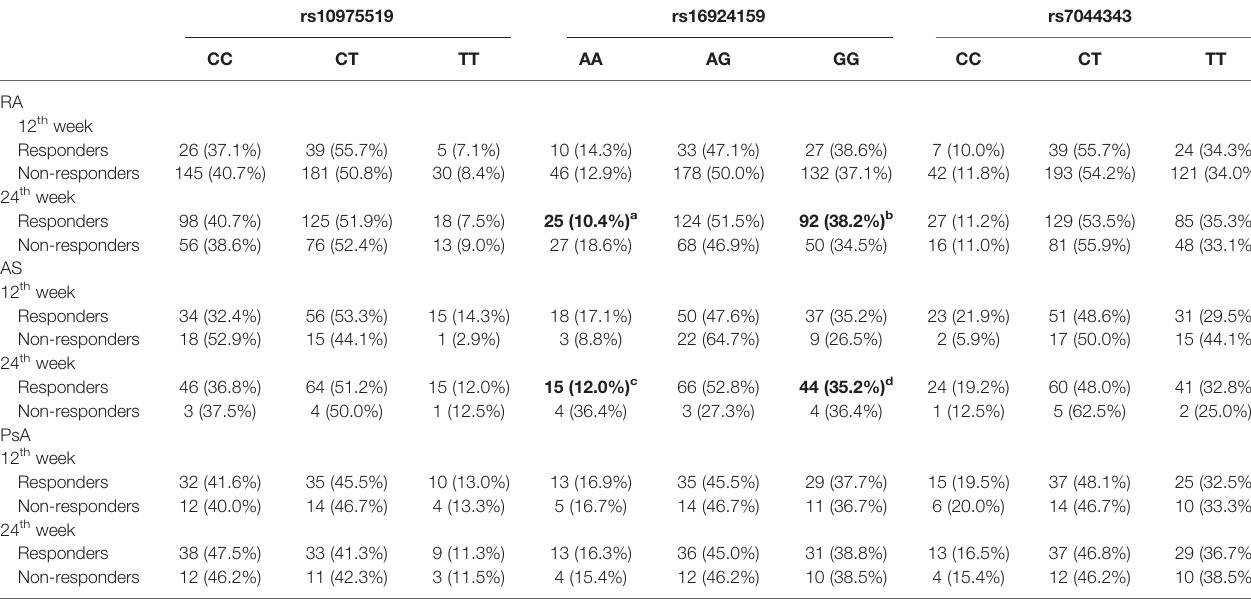
TABLE 4 | Analysis of the IL-33 genotypes distributions with regard to therapeutic response to anti-TNF agents in rheumatoid arthritis, ankylosing spondylitis and psoriatic arthritis